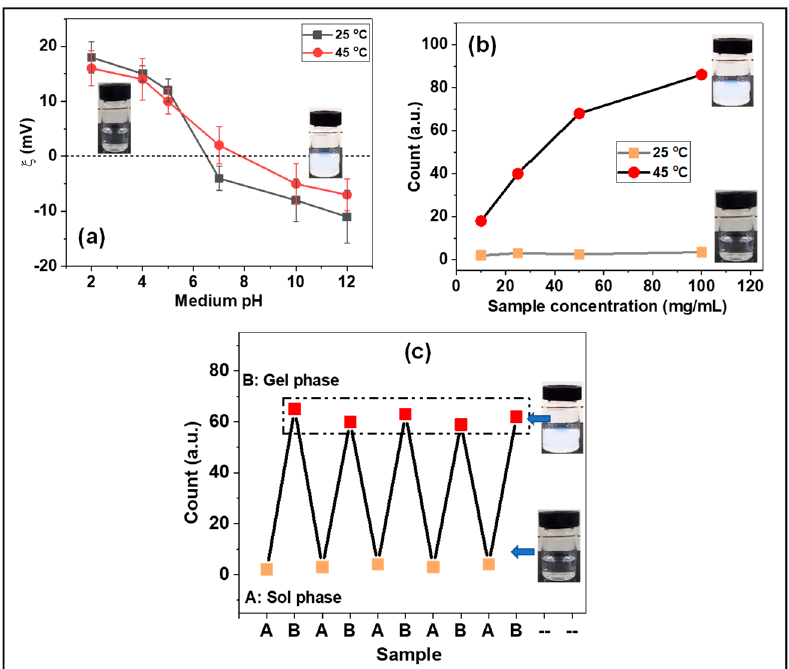
Figure 3. ( a ) Zeta potential and ( b ) particle size of PNIPAm − co − PAAm-Mela HG sample. Mean with error bar n = 3. ( c ) DLS analysis of PNIPAm − co − PAAm-Mela HG at below and above LCST.